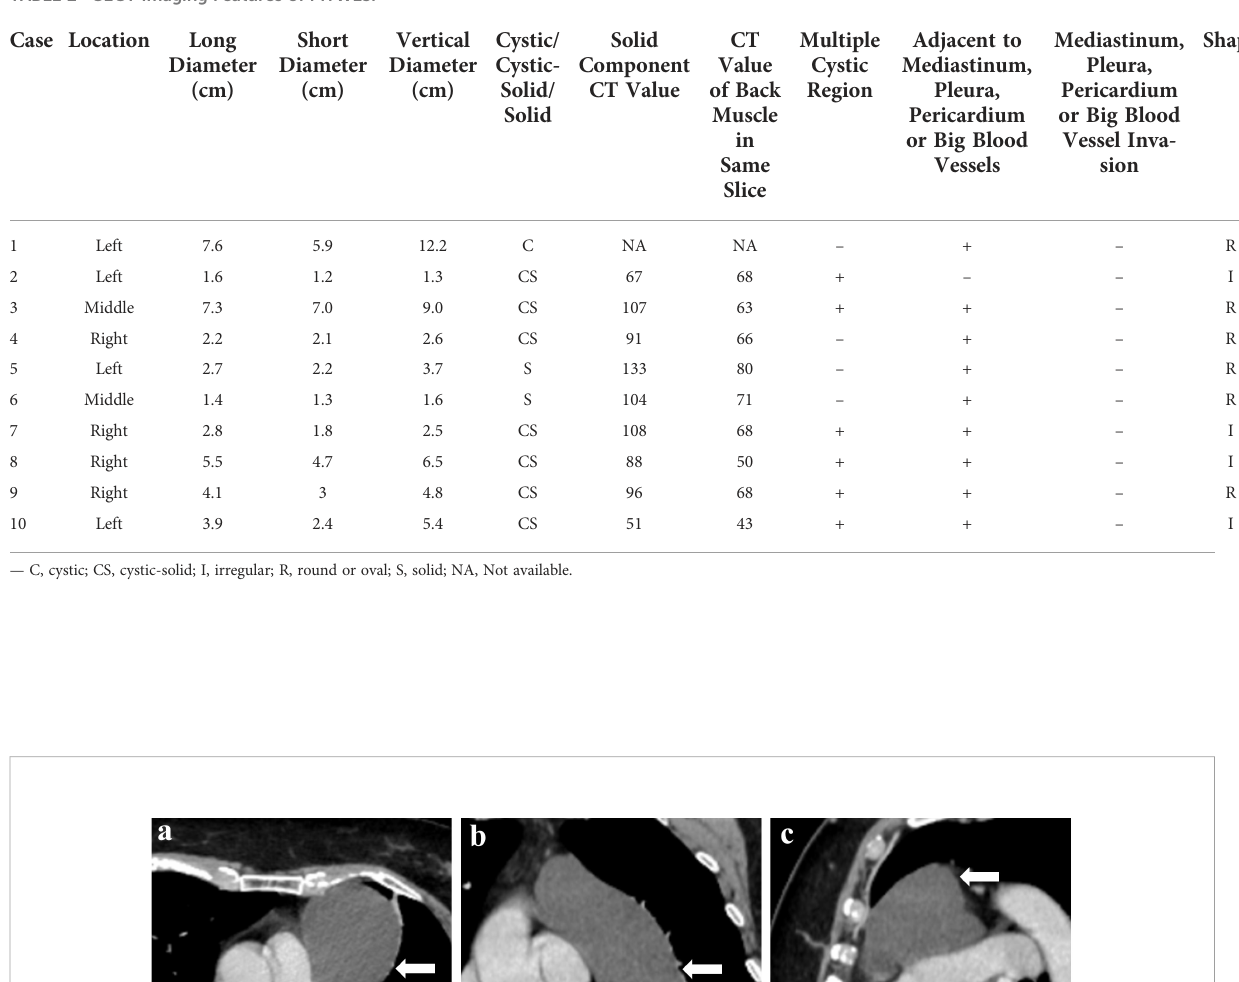
TABLE 2 CECT Imaging Features of MTWLS.